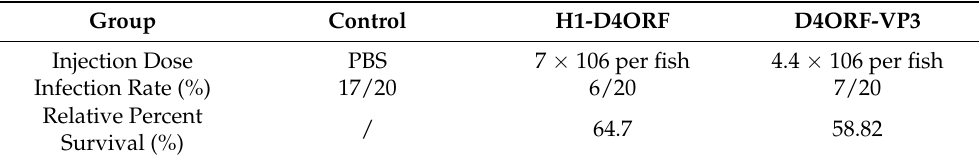
Table 1. Immunoprotection of CyHV-2 infection by immunological injection of recombinant